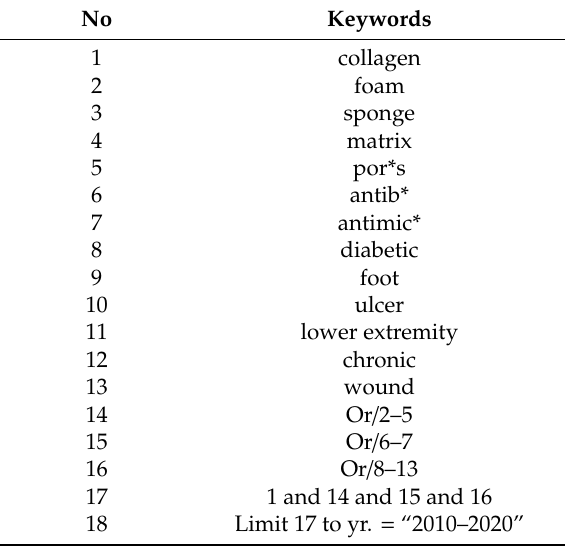
Table 1. Search strategy based on Ovid MEDLINE for systematic literature